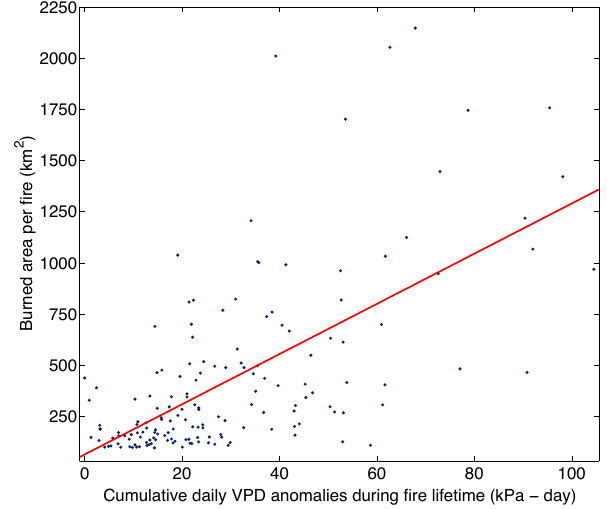
Figure 8. Sum of positive VPD anomalies during a fire lifespan against burned area per fire. This figure includes all fires in the pe- riod 2002-2011 with a duration greater than 1 day R 2 (Linear fit) =